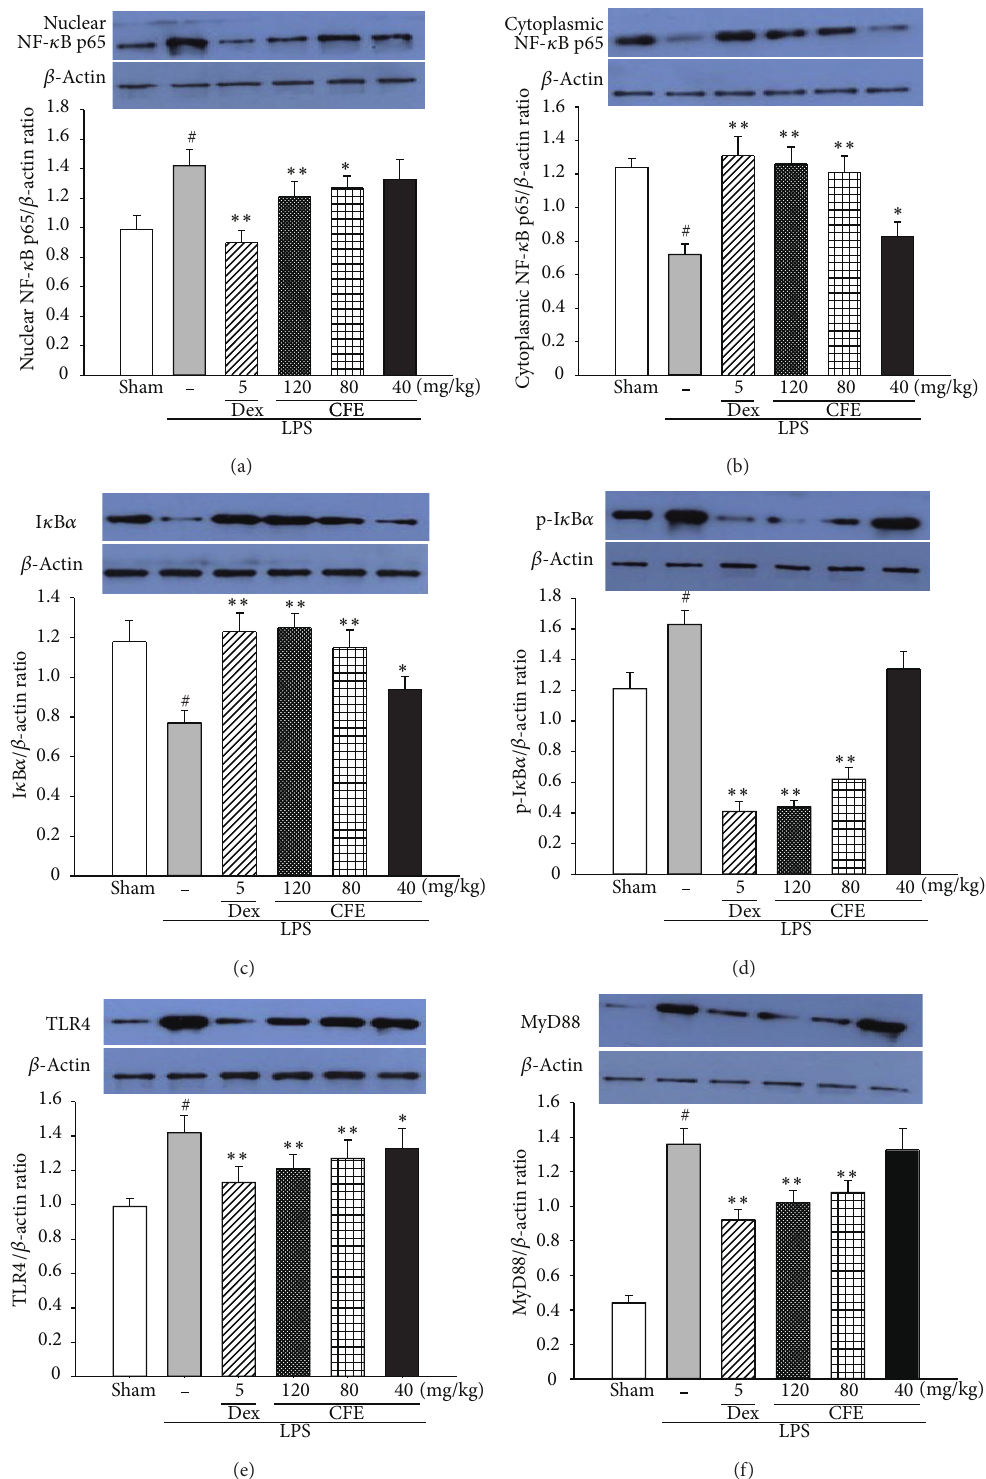
Figure 6: The effects of CFE on TLR4/MyD88/NF- 𝜅 B expressions. The levels of NF- 𝜅 B p65 in nucleus (a), NF- 𝜅 B p65 in nucleus cytoplasm (b), I 𝜅 B 𝛼 (c), p-I 𝜅 B 𝛼 (d), TLR4 (e), and MyD88 (f). Data was represented as the mean ± SEM ( 𝑛 = 10 ). # 𝑃 < 0.01 compared to the sham group; ∗ 𝑃 < 0.05 and ∗∗ 𝑃 < 0.01 compared to the LPS